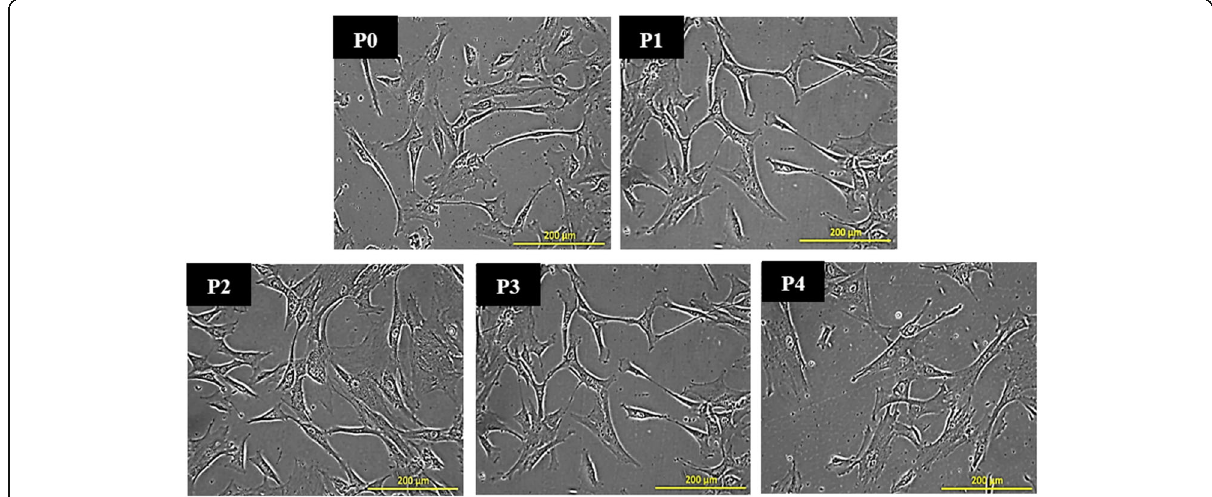
Fig. 1 Phase contrast images of hWJMSCs in culture from the initial passage (P0) to passage 4 (P4). The cells were small to large and exhibited a flat and bipolar/multipolar fibroblastic morphology throughout the culture ( n = 6). Scale bar 200 μ